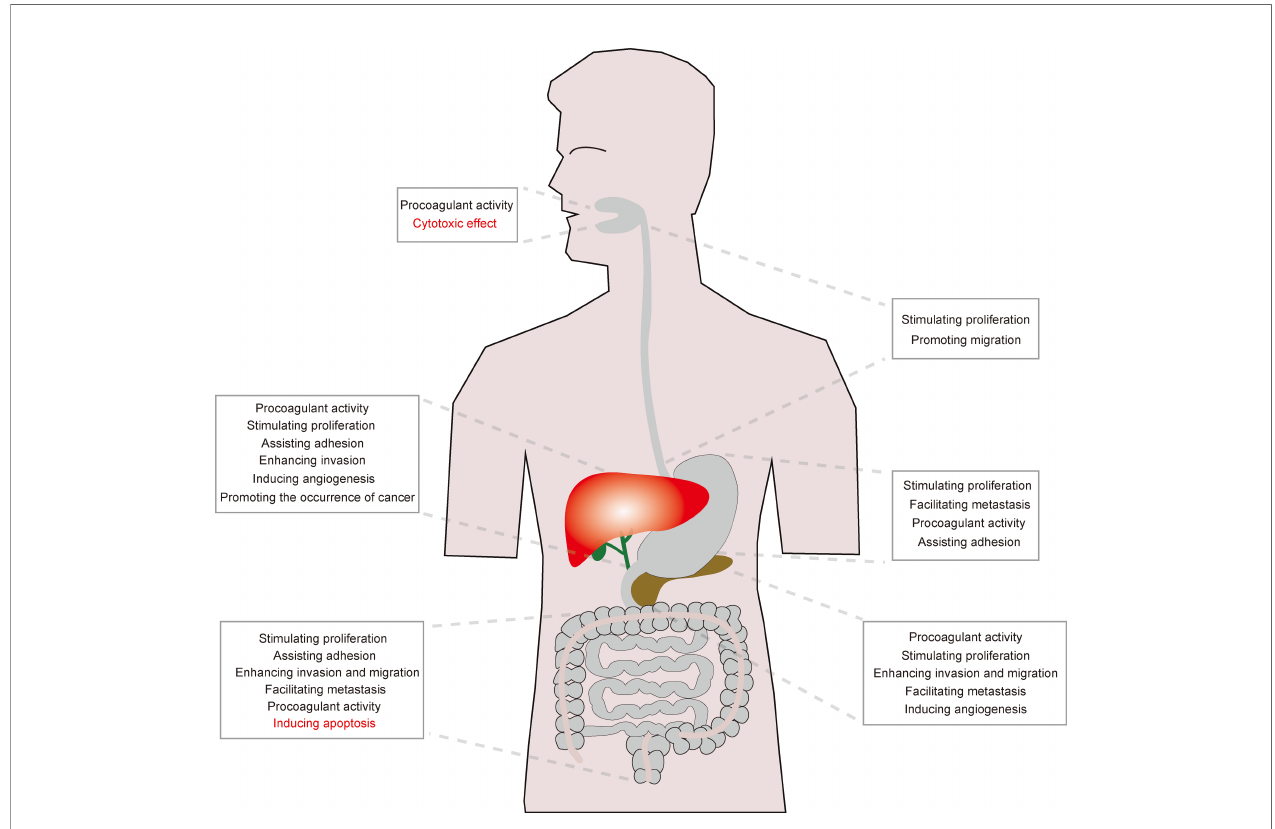
FIGURE 2 | The main effect of NETs on digestive cancers. Although the effect of NETs on OSCC and colon carcinoma remains unclear, NETs mainly play a pro- tumor role in esophageal, gastric, pancreatic, liver and biliary